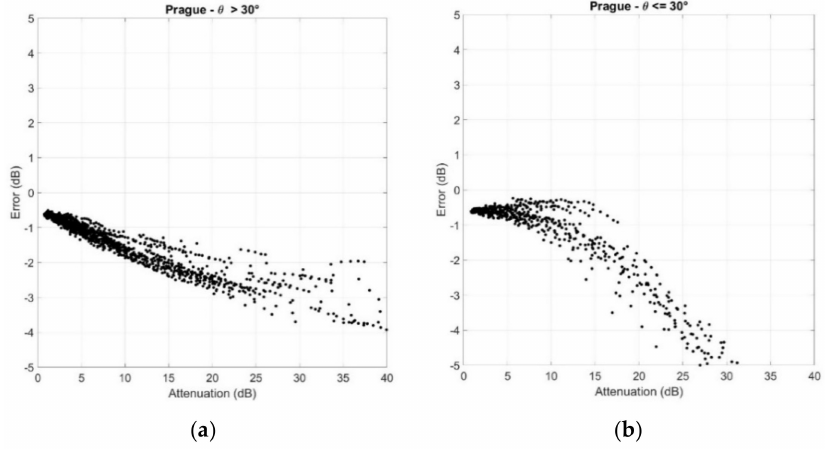
Figure A4. Scatter plots of the error ε = A SST , glo − A SST versus A SST : ( a ) θ > 30 ◦ ; ( b ) θ ≤ 30 ◦ . Prague.